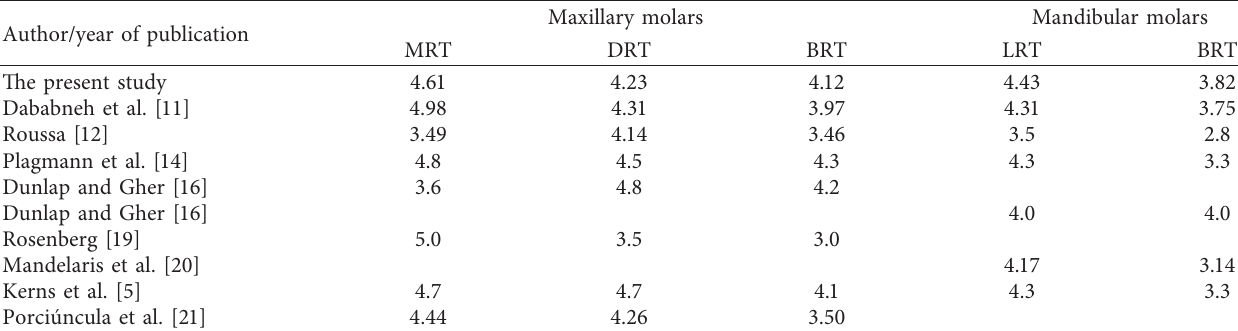
Table 5: Comparison of root trunk dimension of mandibular and maxillary molars between this study and other